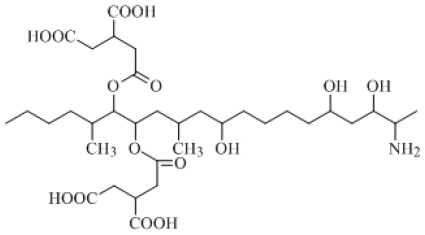
Constitutional formula of FB1.